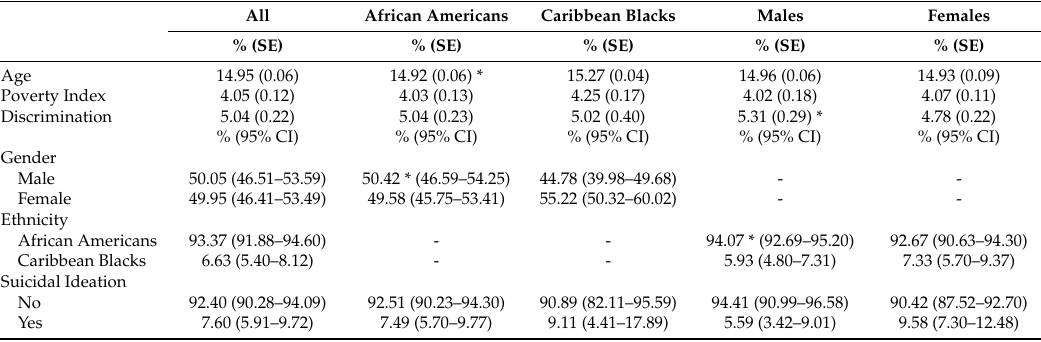
Table 1. Descriptive statistics of the sample overall, and based on ethnicity and gender.